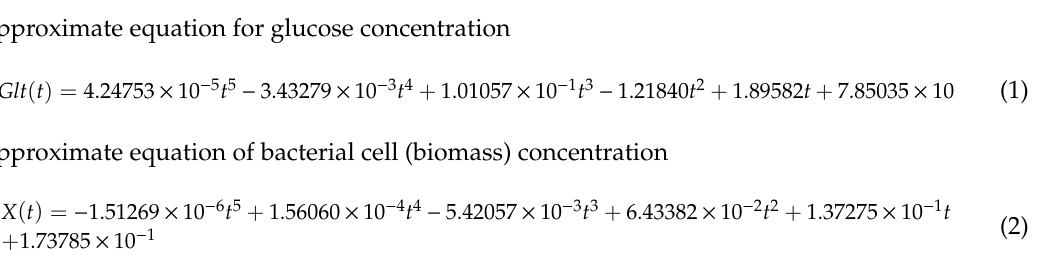
Figure 2. Approximated results of glucose ( a ) and biomass ( b ) concentrations. The symbols indicate measured values extracted from a previous publication by Chen et al. [27], and the lines indicate the results of polynomial approximations.